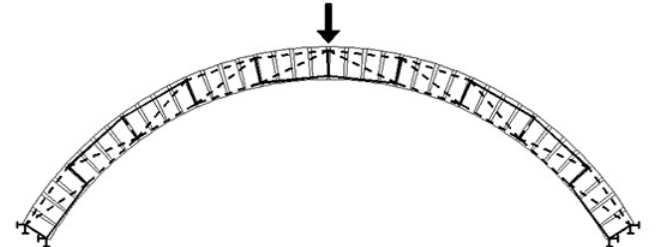
Figure 7. A complete Strut-and-Tie model of the vaults from the first series